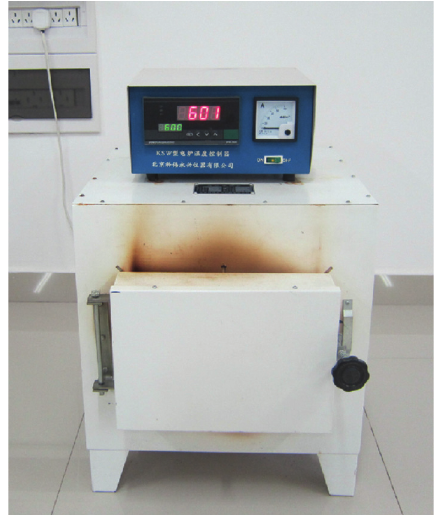
Figure 1: Box-type resistance furnace heated at high